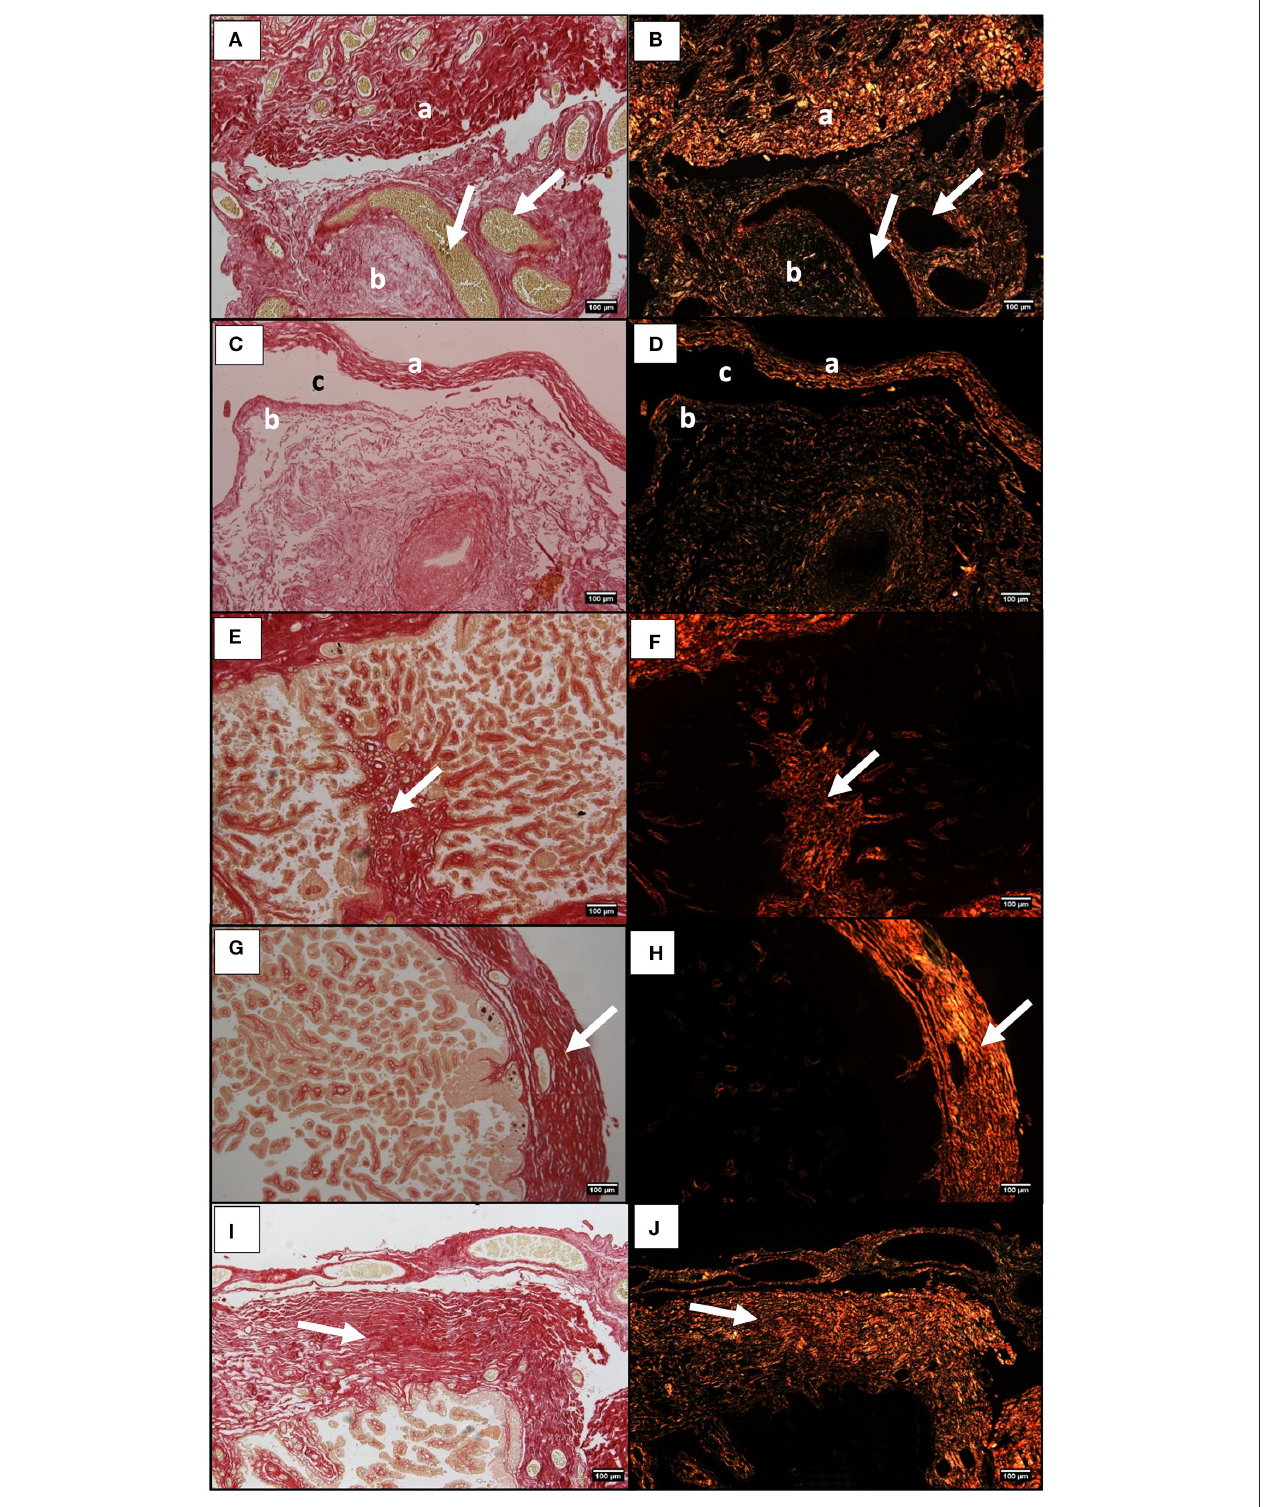
FIGURE 4 | Histological sections of the equine placenta pregnant horn stained with Picrosirius Red and visualized in bright field (A,C,E) and under polarized light (B,D,F) . Red and green colors reflect the orientation of the collagen bundles. (A,B) Chorionic plate connective tissue (a), and allantoic membrane connective tissue (b). White arrows indicate blood vessels. (C,D) Connective tissue adherent to the allantoic epithelium (a), and in the external part of the chorionic membrane (b),